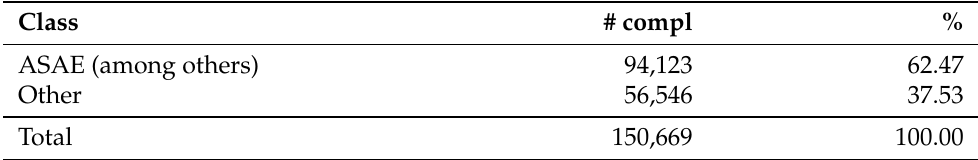
Table 3. Competence class distribution (binary